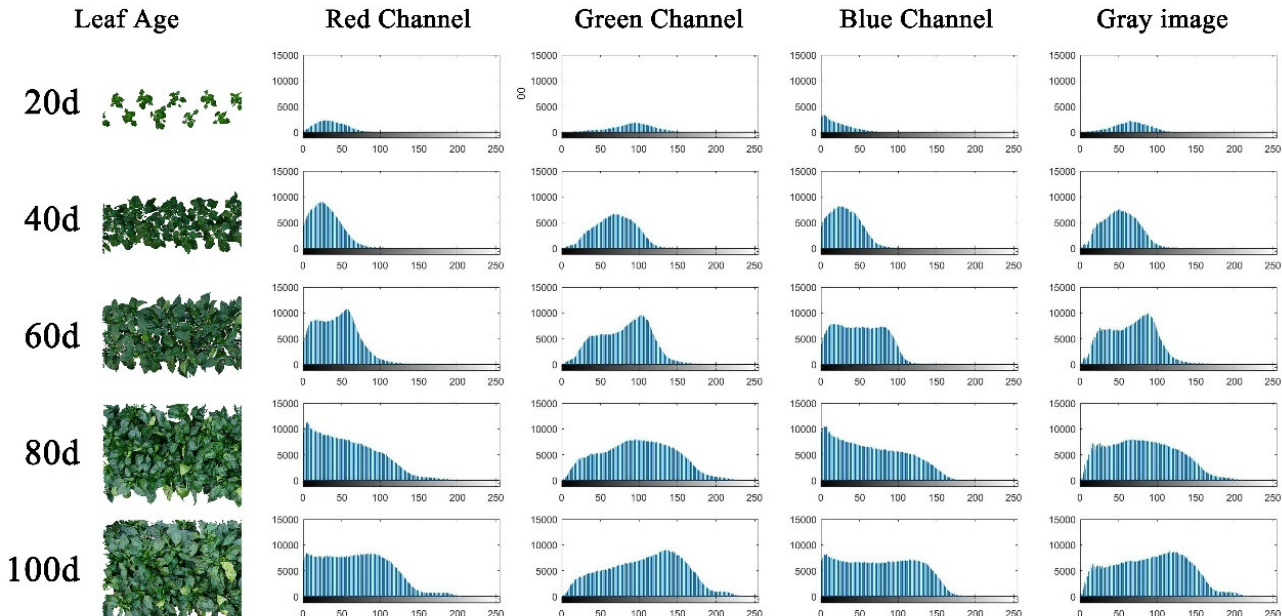
Figure 2. RGB model color gradation distribution of population canopy images of pepper on five different dates. The cumulative frequency histogram of red, green, and blue channels, as well as gray-level images, were drawn using the imhist function of MATLAB. The X -axis is the color gradation value, and the Y -axis is the cumulative frequency.